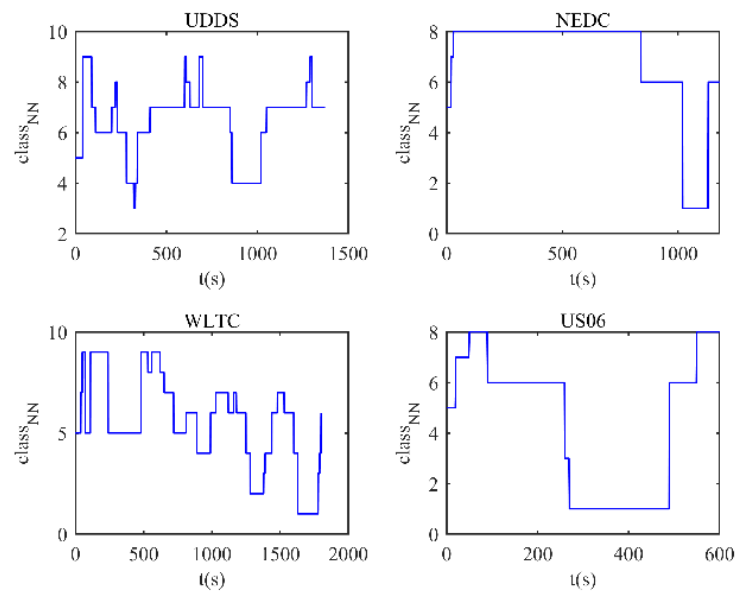
Figure 7. The identification results of four driving cycles.